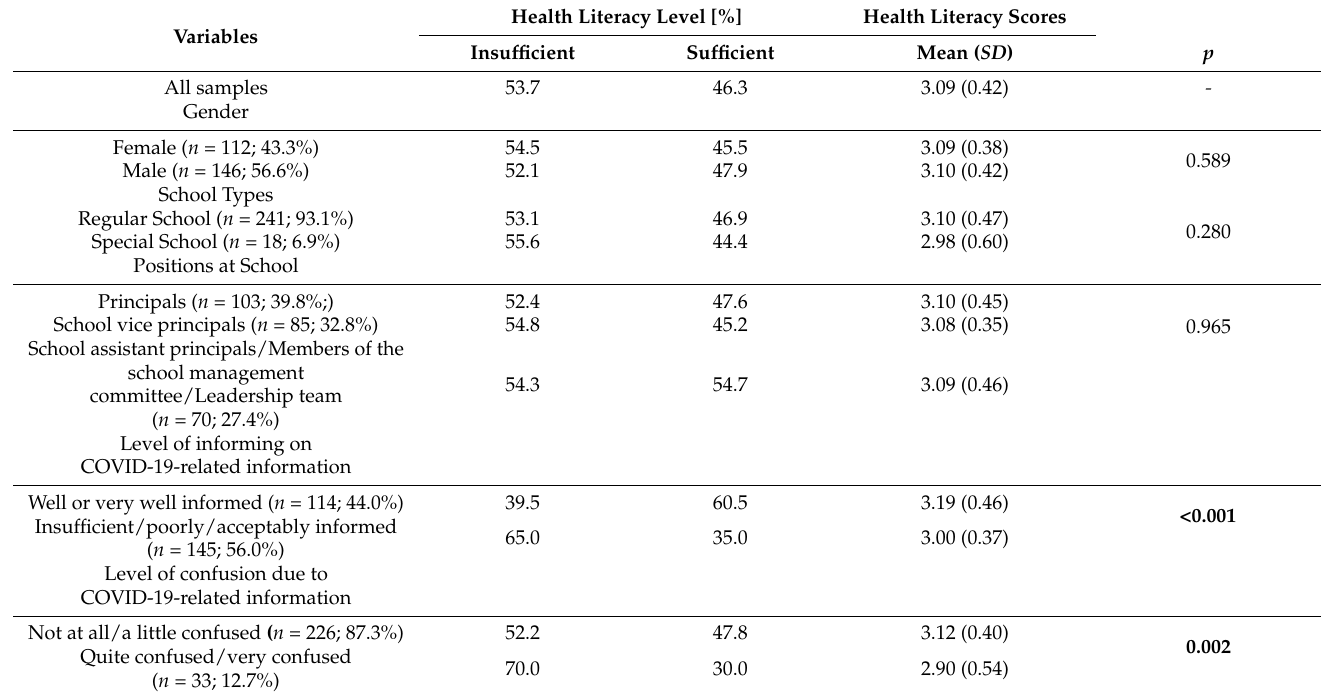
Table 2. Health literacy levels and mean scores by participant characteristics using t -tests and ANOVA.